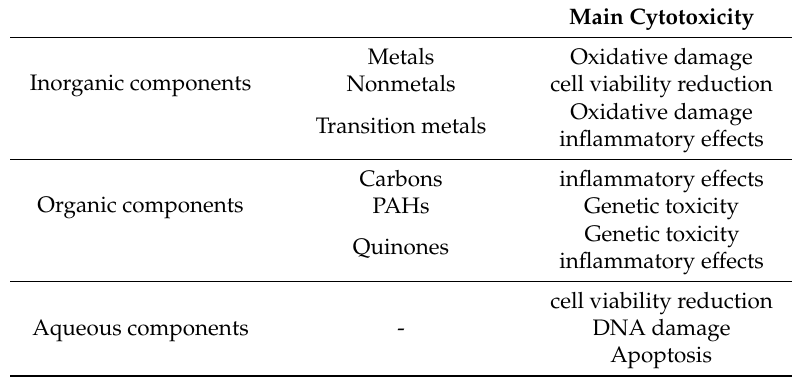
Table 1. Main cytotoxicity of different PM 2.5 components. PAH: polycyclic aromatic